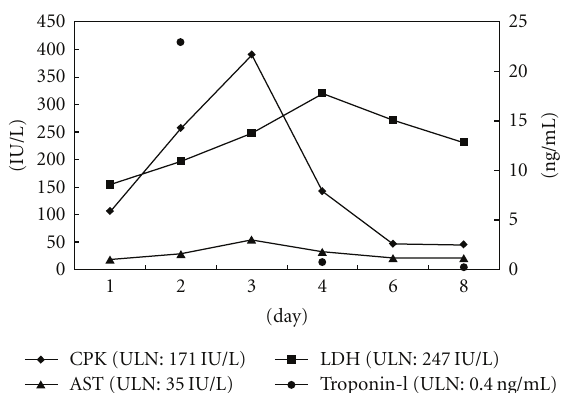
Figure 1: Laboratory results of cardiac biomarkers during hospi- talization in a patient with Salmonella enteritidis associated acute